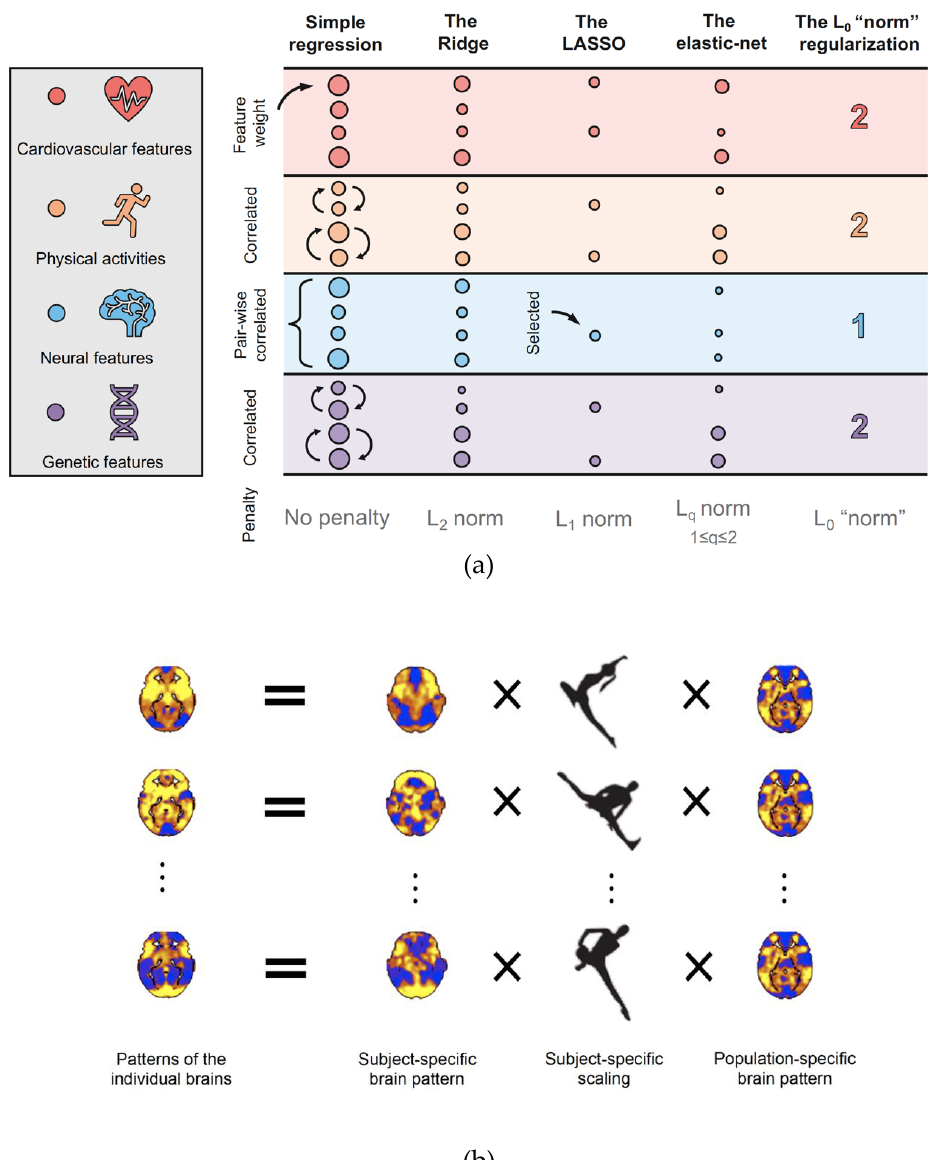
Figure 3. Schematic representations of data reduction on large-scale multivariate features via regularization and decomposition. ( a ) Using regularization techniques to select features. Four common regularization approaches, the Ridge, the LASSO, the elastic-net, and the L 0 “norm” regularization,